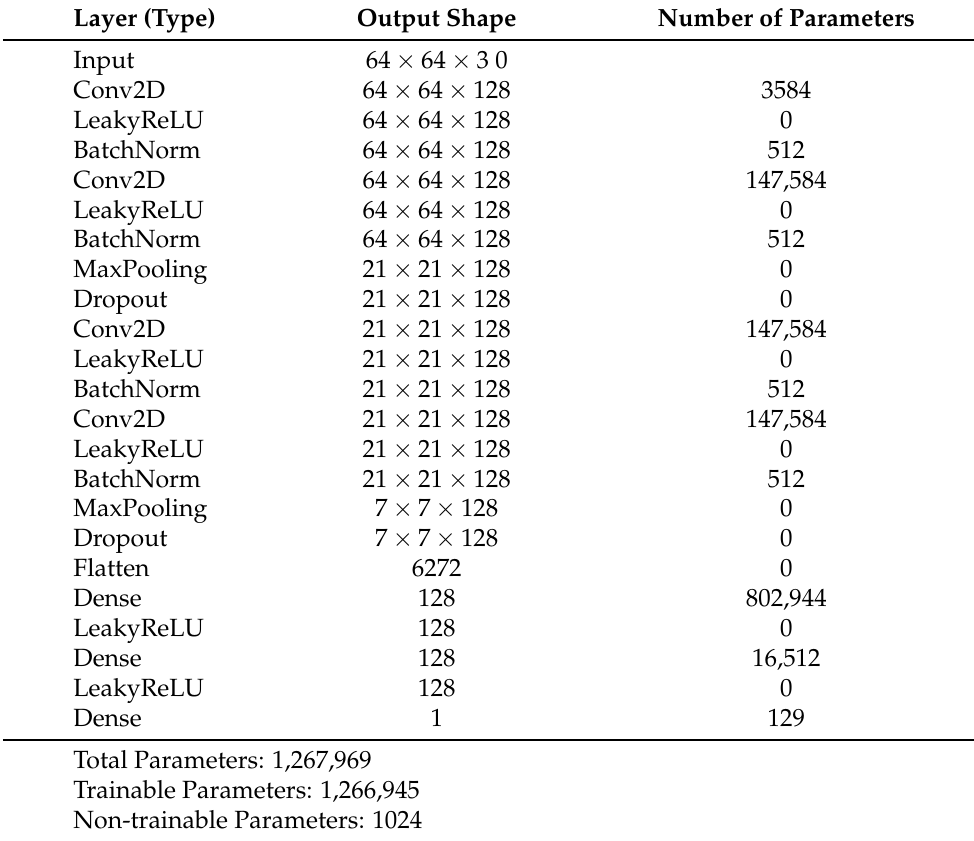
Table 3. The architecture of the